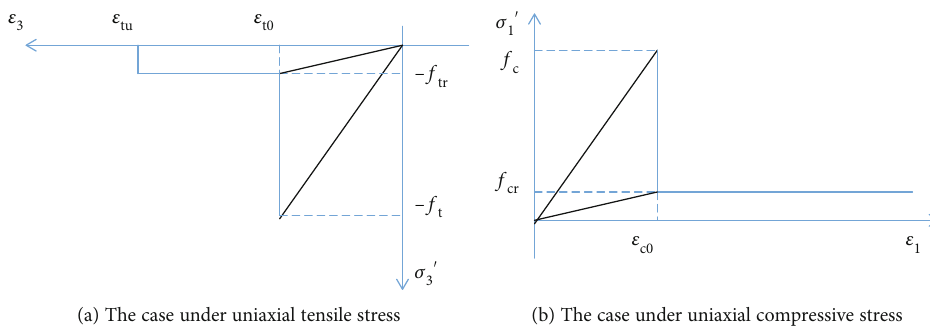
Figure 1: Elastic-brittle damage constitutive law of an element subject to uniaxial stress [18, 35, 40,